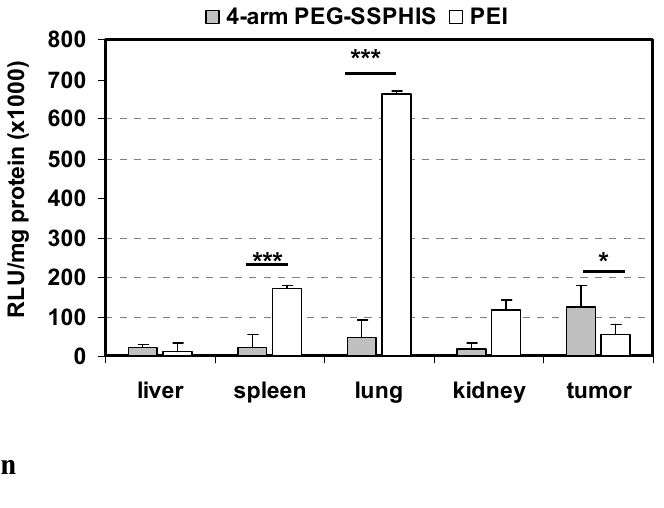
Figure 6. Luciferase expression in the tumor and organs of nude mice after intravenous injection of 4-arm PEG-SSPHIS-based polyplexes (30 μ g DNA, at mass ratio of 12/1). The expression was presented as RLU/mg protein ( n = 4). A formulation of PEI at an optimal mass ratio of 1/1 was used as a control. * p < 0.05, *** p <